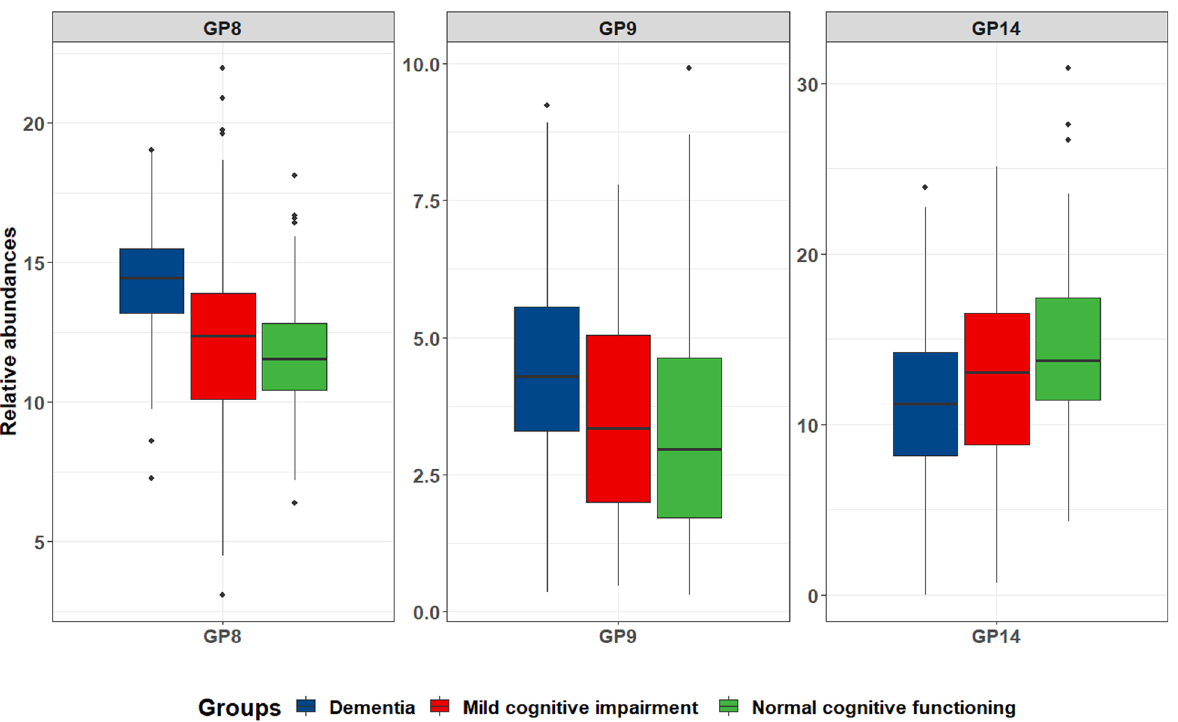
Fig. 4 The distribution of a panel of biomarkers (GP8, GP9 and GP14) within the dementia, mild cognitive impairment (MCI), and normal cognitive functioning (NC) groups. The box plots show the distribution of GP8, GP9, and GP14 in dementia (blue), MCI (red), and NC (green) groups. The following values correspond to center line, upper/lower bounds, and whisker max/min for dementia, MCI, and NC groups, respectively: GP8 : center line (median): 14.46, 12.35, 11.53; lower/upper bounds ( P 25 / P 75 ): 13.11/15.57, 10.02/13.91, 10.35/12.87; whiskers max/ min: 19.01/7.27, 21.96/3.09, 18.10/6.38; GP9 : center line (median): 4.29, 3.35, 2.97; lower/upper bounds ( P 25 / P 75 ): 3.29/5.58, 2.00/5.06, 1.72/4.64; whiskers max/min: 9.23/0.36, 7.78/0.47, 9.91/0.31; GP14 : center line (median): 11.24, 13.02, 13.73; lower/upper bounds ( P 25 / P 75 ): 7.89/14.26, 8.74/16.56, 11.43/17.54; whiskers max/min: 23.87/0.01, 25.14/0.69,